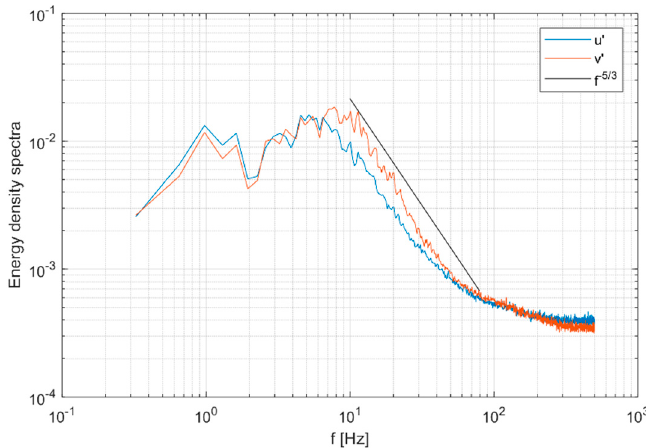
Figure 18. Spectral energy density for turbulent fluctuations, u’. Five-thirds law plotted for reference.